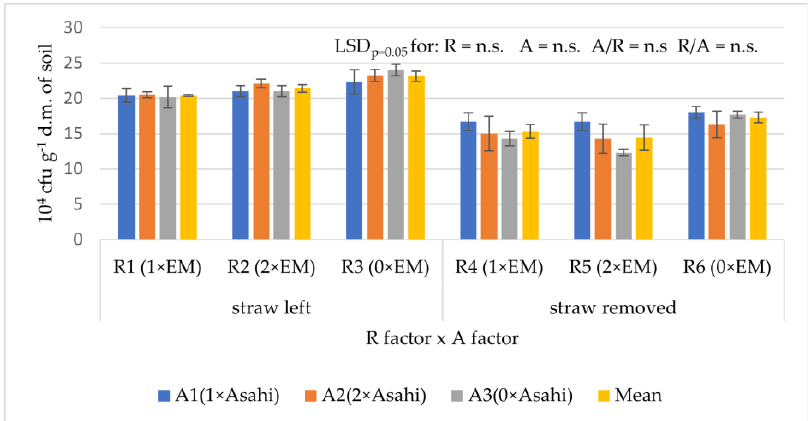
Figure 3. The number of filamentous fungi in the soil depending on the management of plant residues with the addition of the biopreparation EM (R factor) and the application of the biostimulant Asahi (A factor) in spring barley cultivation. Error bars represent standard deviation (abbreviations: see Table 1).